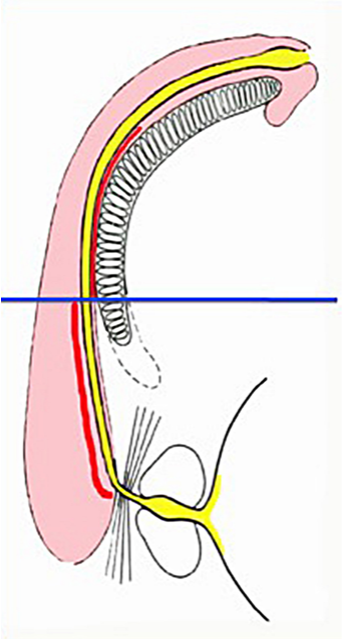
Figure 1 - The different location of the graft (in red) according to the thickness of the spongiosum tissue: dorsal location on the distal bulbar urethra, ventral location on the proximal bulbar urethra.